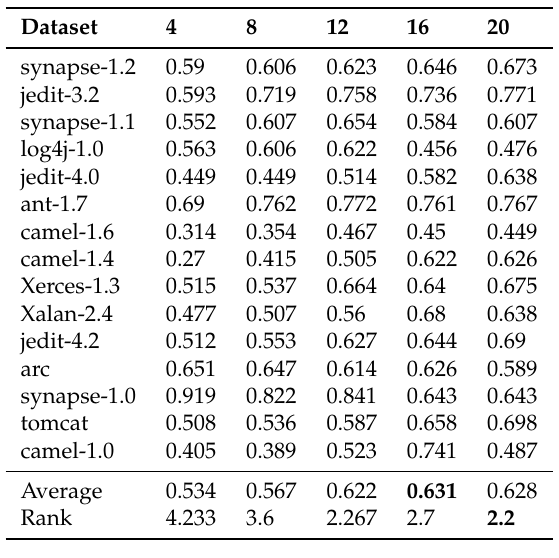
Table 15. G-mean of different number features in GNB with LIMCR on small datasets.